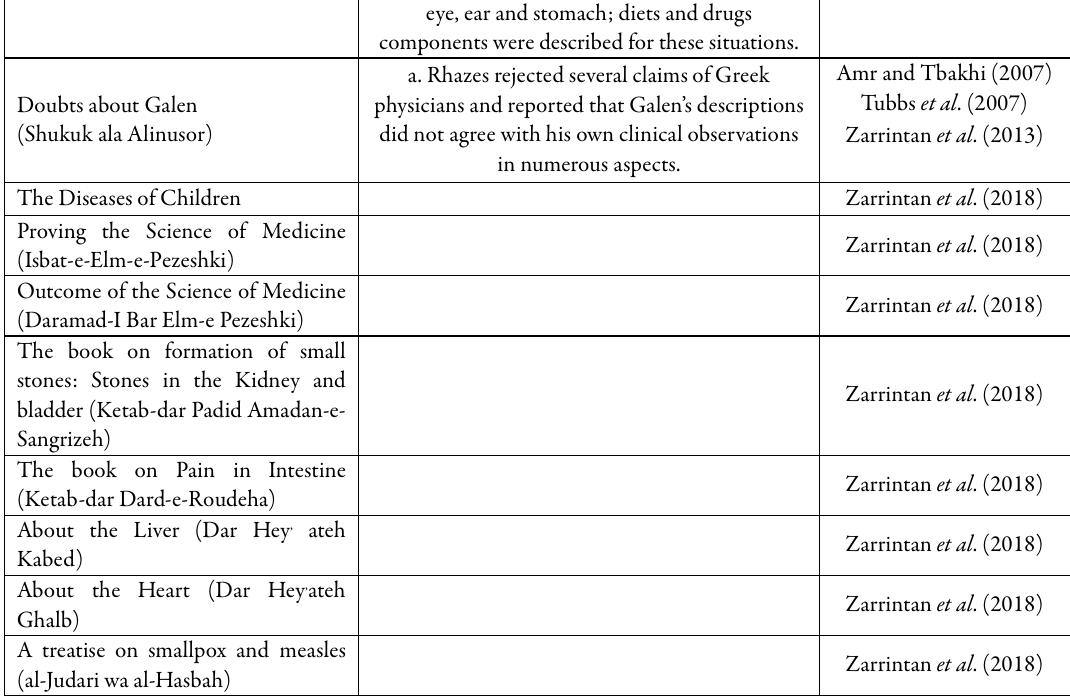
Table 15. Reported findings and suggestions of Rhazes for different